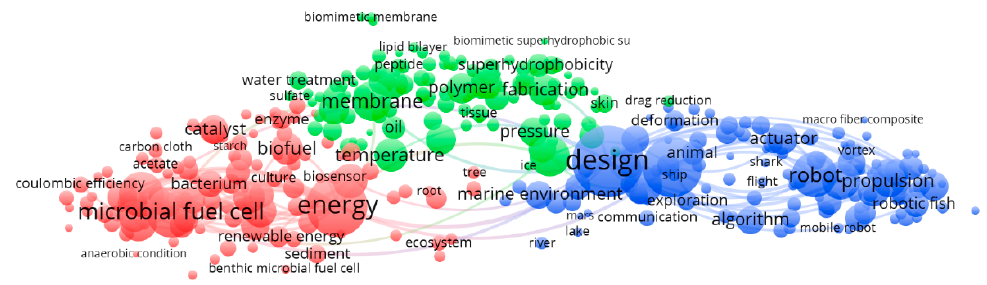
Figure 4. Term-map analysis based on biomimicking publications. Different colors represent the terms belonging to different clusters. Terms are represented by a circle (node), whose diameter and the label size represent the number of publications, where that term appears. Top 100 linkages were represented.